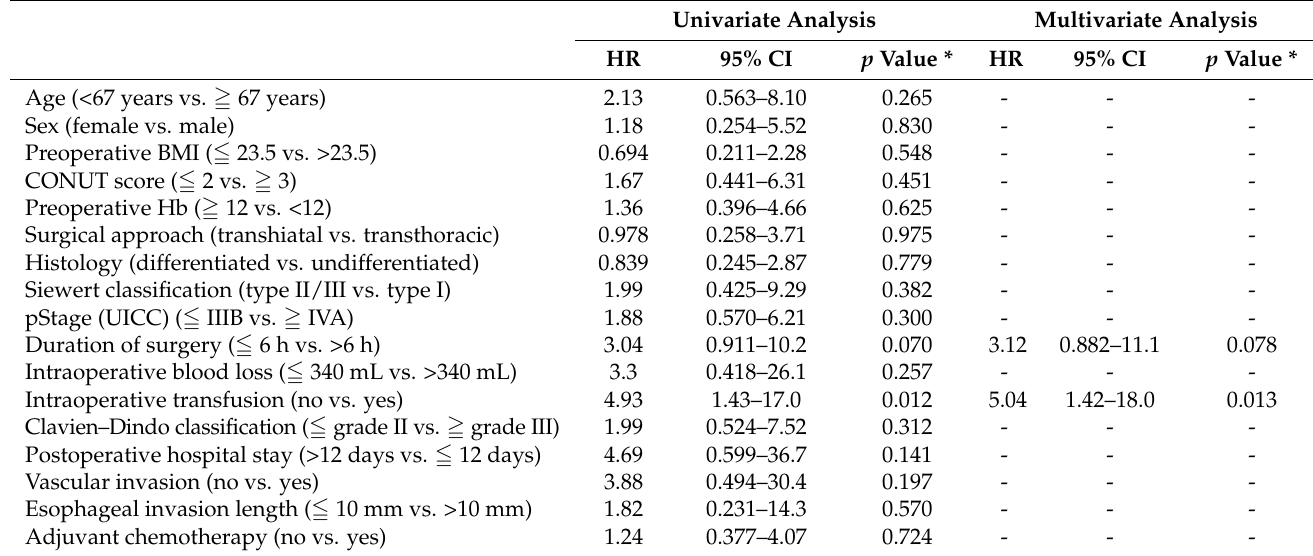
Table 6. Cox proportional hazards model for overall survival (excluding patients who had undergone minimally invasive